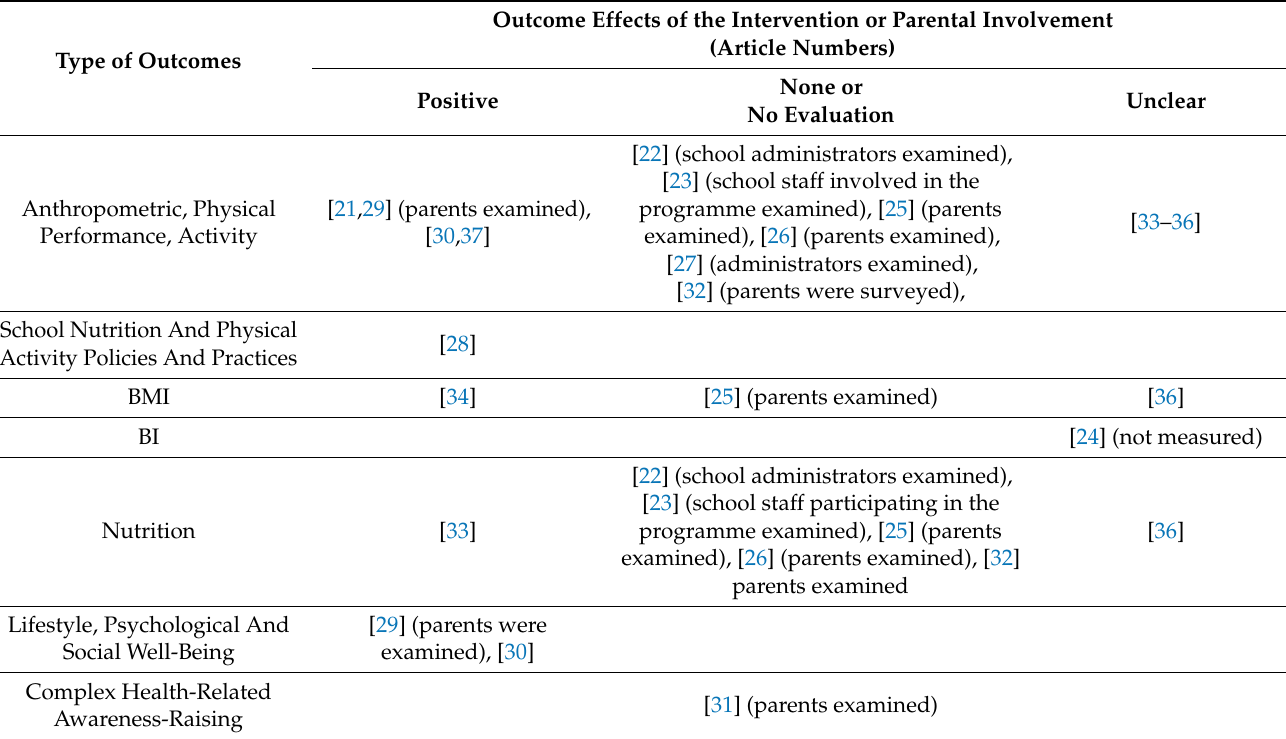
Table 5. Outcome effects of the intervention or parental involvement according to the type of